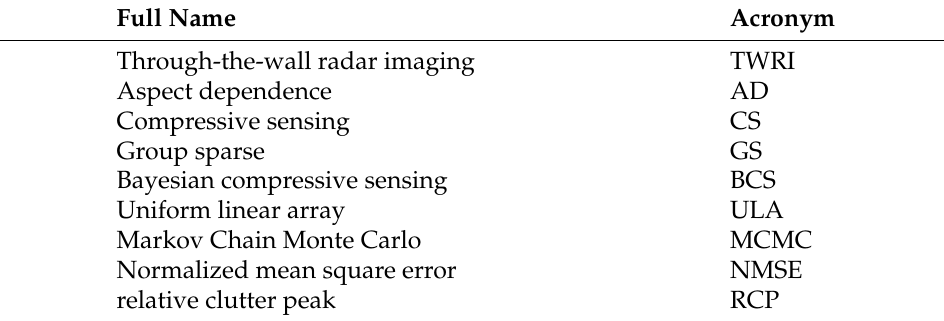
Table 1. Table of major full names and